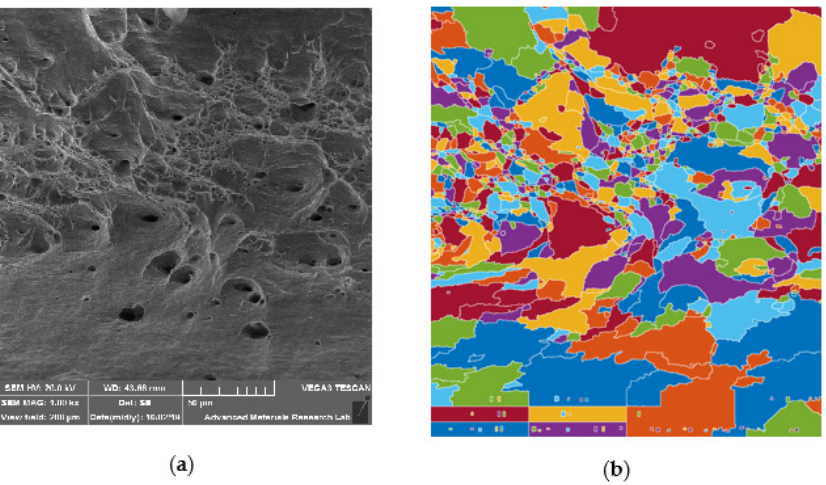
Figure 16. Dimple size analysis for UT specimen: ( a ) SEM image at 1000×; ( b ) Processed image.